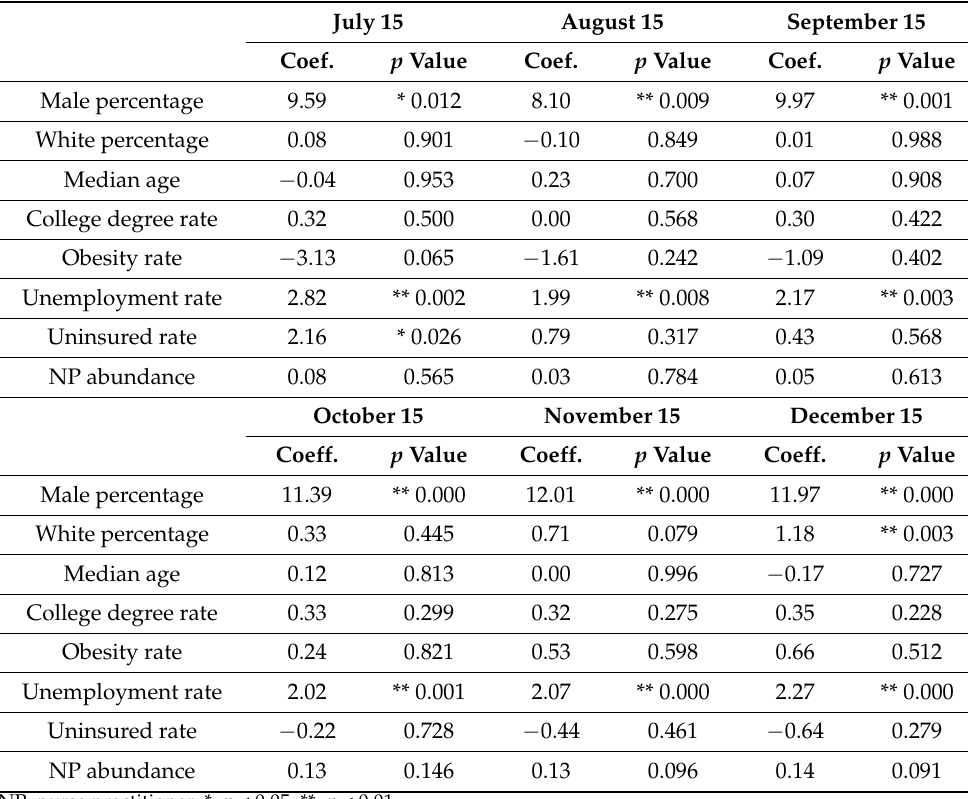
Table 4. Coefficients of the explanatory variables in the CAR